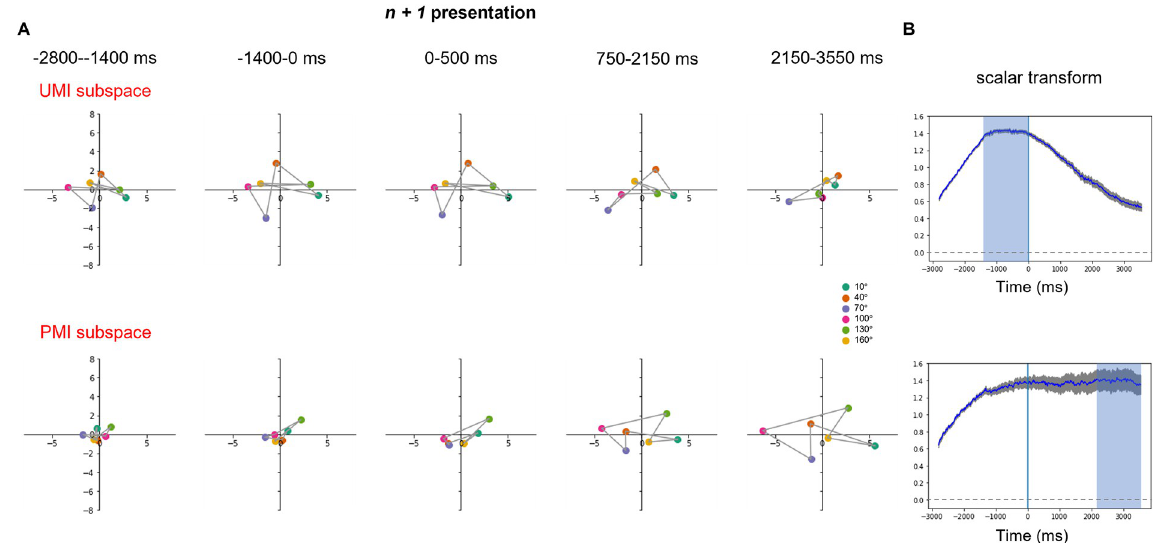
Fig 6. Stimulus trial-averages of EEG signal projected into UMI and PMI subspaces over a 2-delay time course (-2800ms to 3550ms relative to stimulus n + 1 onset). (A) Results from an example subject. Dot color indicates stimulus n ’s orientation angle. Data points of adjacent stimulus orientation angles are connected by a gray line. (B) Group-average time course of scalar transform over the course of a trial (N = 42). Blue vertical line indicates the onset of stimulus n + 1 . Light blue shading shows the time windows that were used to identify the dPCs. The gray shading around the curve shows standard error of the